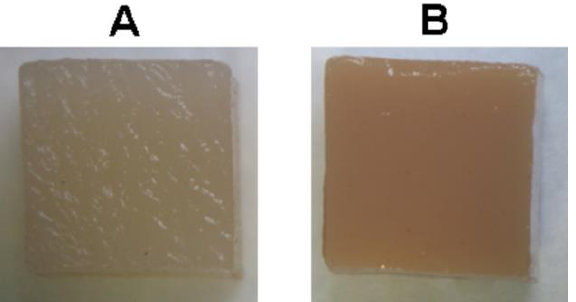
Figure 16. Appearance of the CaP ( A ) and FeP ( B ) hydrogel cubes for compression tests.